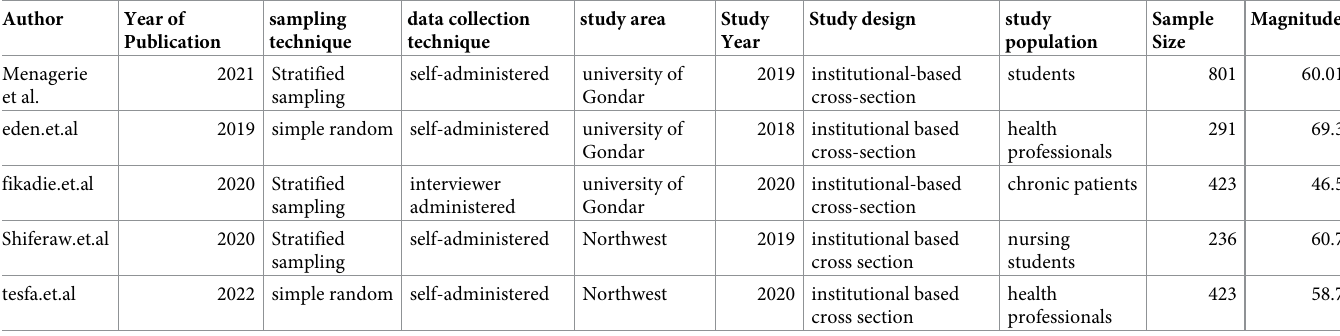
the results of the funnel plots and Egger’s regression test in this meta-analysis revealed the Table 1. Characteristics of individual studies done on eHealth literacy in Ethiopia